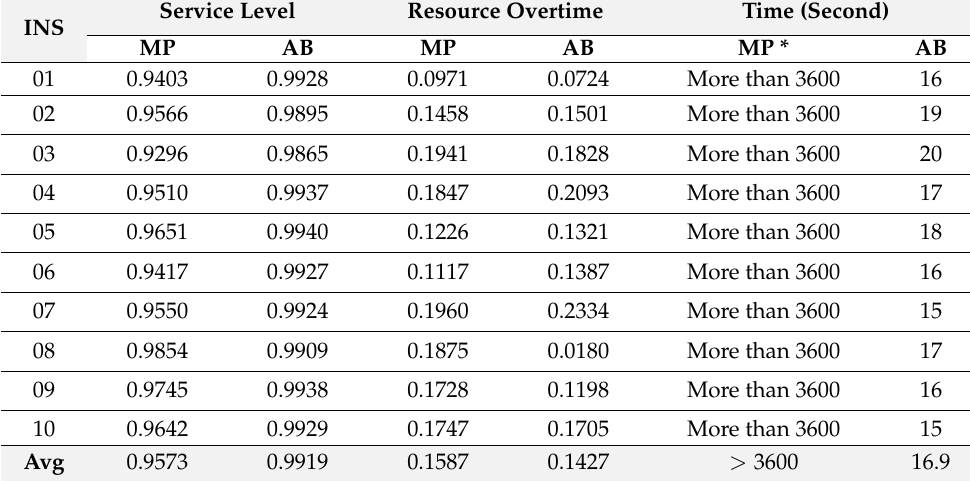
Table 4. Result of large size problem (EC PART III).